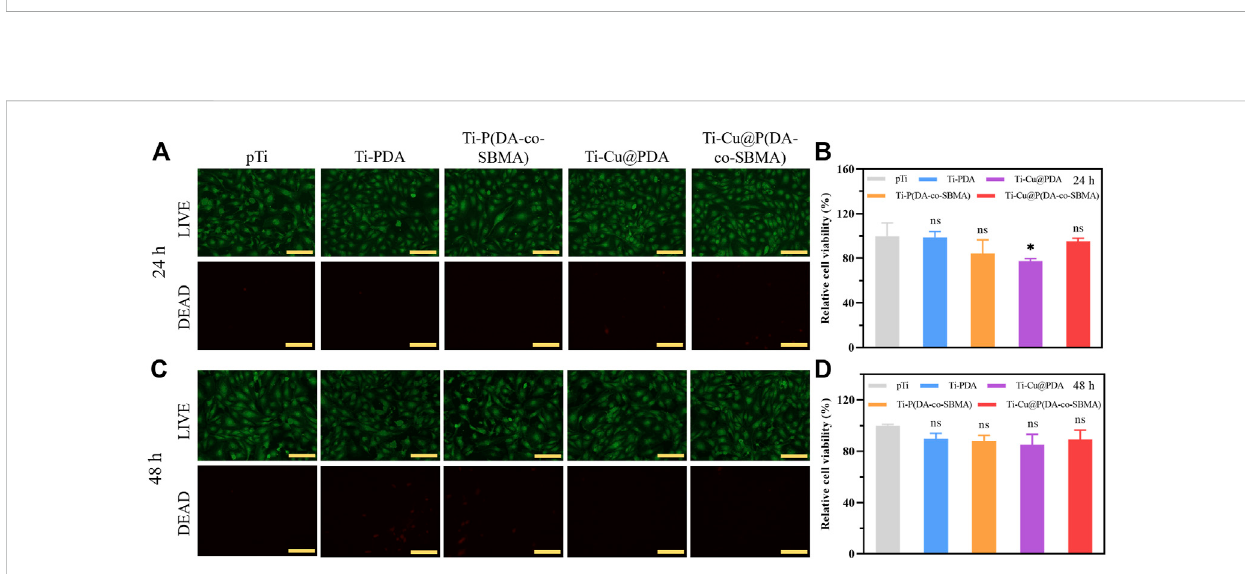
FIGURE 8 Fluorescent images of LIVE/DEAD staining of HUVECs after incubation with pTi, Ti-PDA, Ti-P(DA-co-SBMA), Ti-Cu@PDA and Ti-Cu@P(DA-co- SBMA) for (A) 24 hand (C) 48 h.Relative cell viability ofHUVECsafter incubation withpTi, Ti-PDA,Ti-P(DA-co-SBMA),Ti-Cu@PDA and Ti-Cu@P(DA-co- SBMA) for (B) 24 h and (D) 48 h ( ns p > 0.05, *p < 0.05). Scale bar: 150 μ